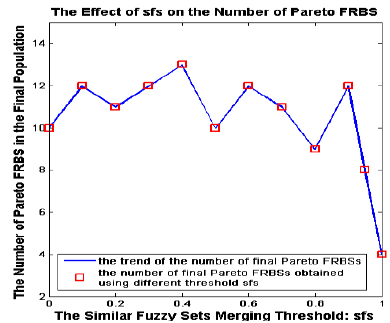
Fig. 16. The effects of sfs on the number of Pareto FRBSs.